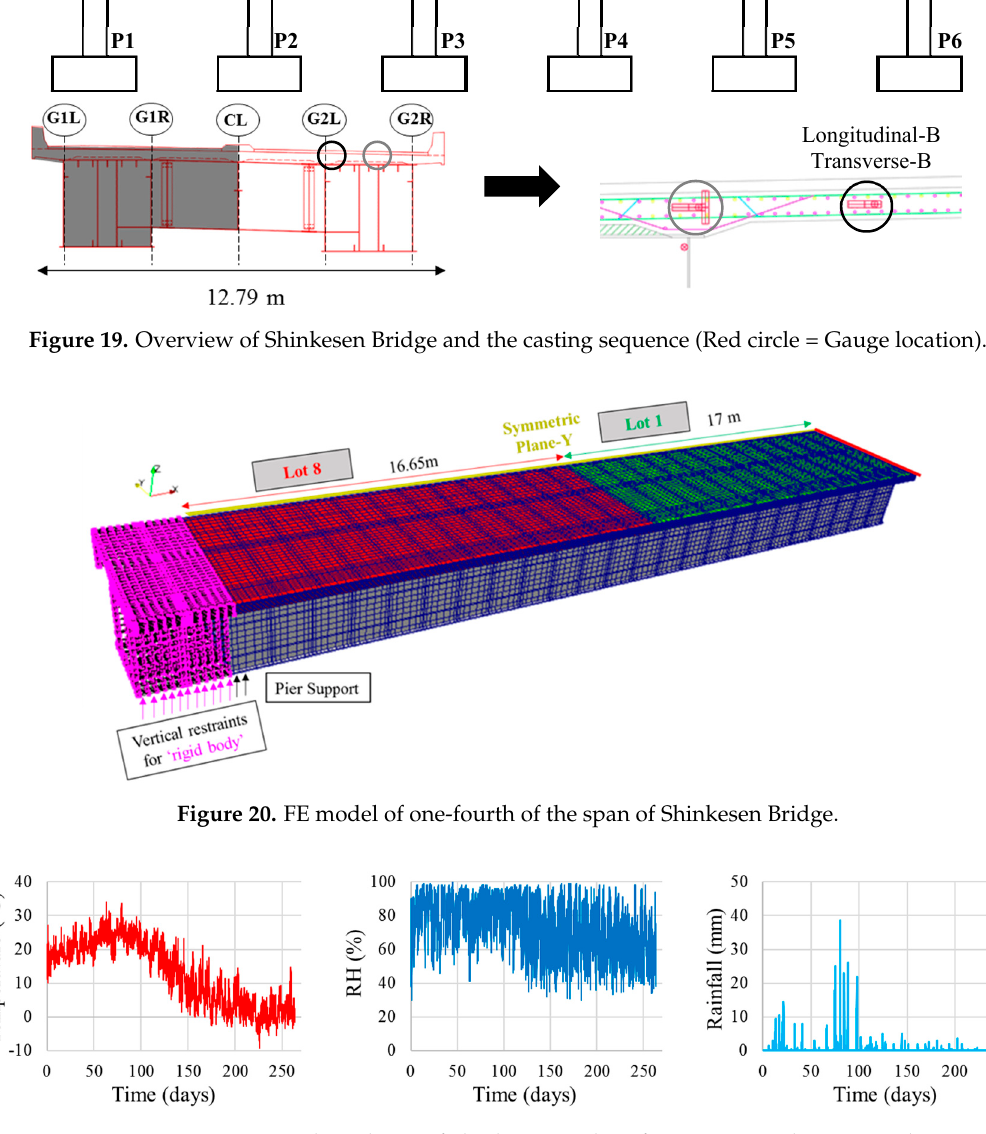
Figure 21. Environmental condition of Shinkesen Bridge after Lot 1 casted up to 250 days.